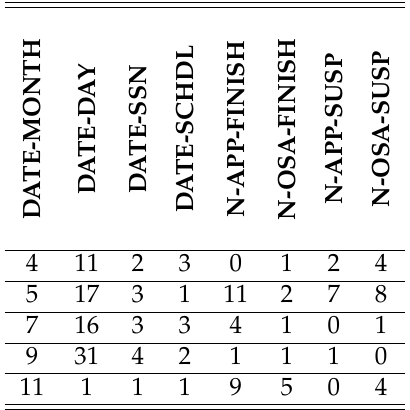
Table 7: Extract from the prepared